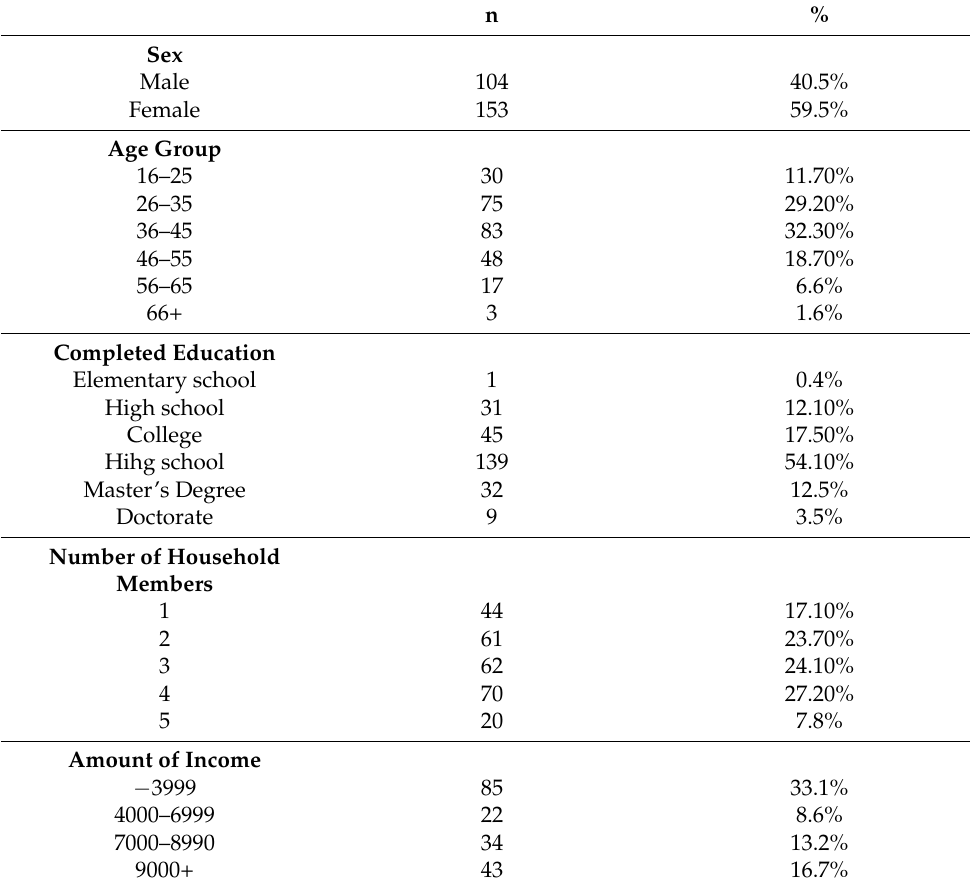
Table 1. Sodio-demographic structure of respondents (n =